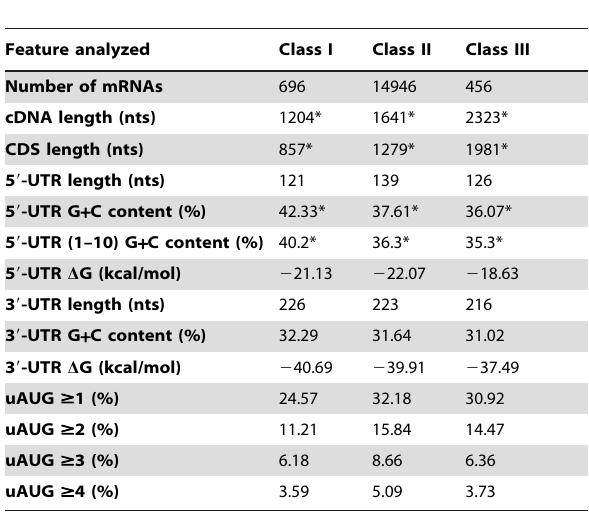
Data sets for the indicated parameters of the representative gene models (n=16098) were retrieved and analyzed as stated in Materials and Methods. Values are expressed as medians or as percentage when stated. Cumulative curves were plotted separately for all the features analyzed (data not shown). K–S test was used to validate the variations in the distribution of the individual features among the established groups, using Class II as reference. Statistically significant differences, with correlation with the relative translation efficiency, were highlighted by an asterisk (p ,